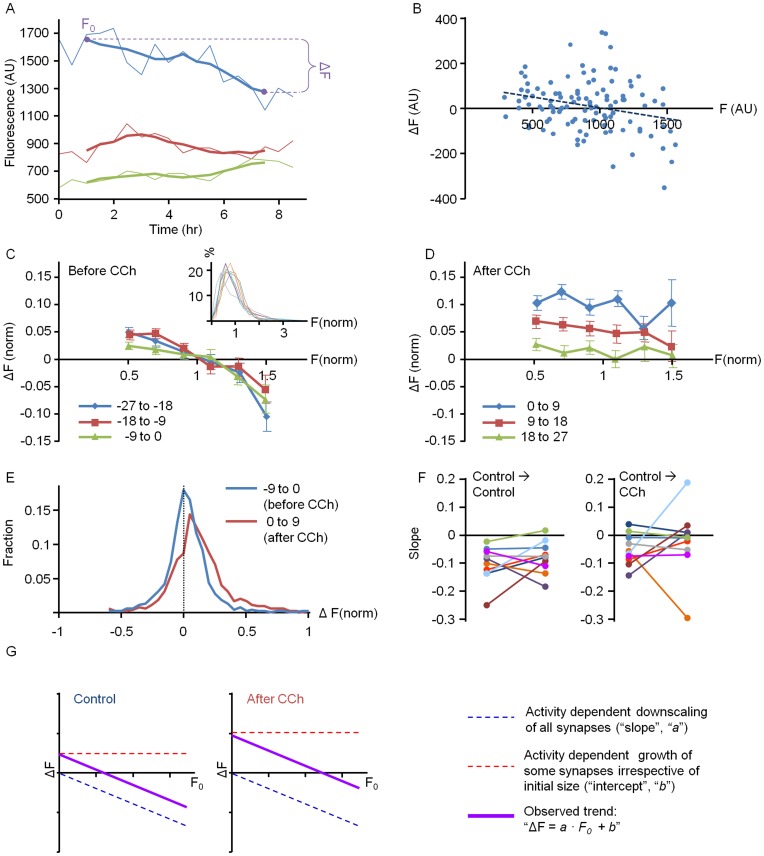
CCh-induced synaptic growth is not governed by multiplicative scaling or major changes in synaptic remodeling dynamics.
A) Example of fluorescence values for 3 PSD-95:EGFP puncta over a 9 hour time window (thin lines) and after smoothing with a 5-point (2 hour) low pass filter (thick lines). The calculation of ΔF and F0 in subsequent figures is illustrated for the topmost trace. ΔF was calculated by subtracting the fluorescence at the beginning of each time window (F0) from the fluorescence at its end. As all such measurements were obtained from data smoothed with a 5 point filter, F0 and ΔF were measured from the third data points from the beginning and the end of each 9 hour (18 data point) window. B) ΔF vs. F0 values for all tracked PSD-95:EGFP puncta in one site during a time window preceding CCh application. Note the significant changes in puncta fluorescence values (even after smoothing as showed in A) and a general trend which can be approximated by a linear regression fit with a negative slope that crosses that abscissa quite far from the origin. C,D) Averaged ΔF over F0 plots for pooled data (1087 puncta from 10 neurons from 5 separate experiments) before and after CCh application. Individual puncta of 2 neurons per experiment were followed for 54 hours (27 hours before and 27 hours after CCh application). To correct for cell to cell variability in PSD-95:EGFP expression levels, the fluorescence values of each neuron’s synapses were normalized to the average synaptic fluorescence of that neuron during the 27 hour period before CCh application (see Materials and Methods for further details). Thus, normalized ΔF and F0 values are expressed as fractions of mean control fluorescence. As shown in C (inset), distributions of normalized synaptic fluorescence values in almost all neurons were very similar, indicating that this normalization procedure is appropriate. Data was then combined, binned (bin size  = 0.2 mean fluorescence units) and plotted, including only bins that contained at least 45 synapses (∼5% of the data). E) Distribution of ΔF values for 9 hour windows before and after CCh applications. F) Changes in the slopes of ΔF vs. F0 regression fits between consecutive time windows before and after CCh application plotted for each cell separately (control → control: −27 to −18 vs. −18 to −9; control → CCh: −9 to 0 vs. 0 to 9). G) Illustration of the two components presumed to give rise to the overall trends observed in ΔF vs. F0 plots before (left) and after (right) CCh application. Data in C,D, mean ± SEM.